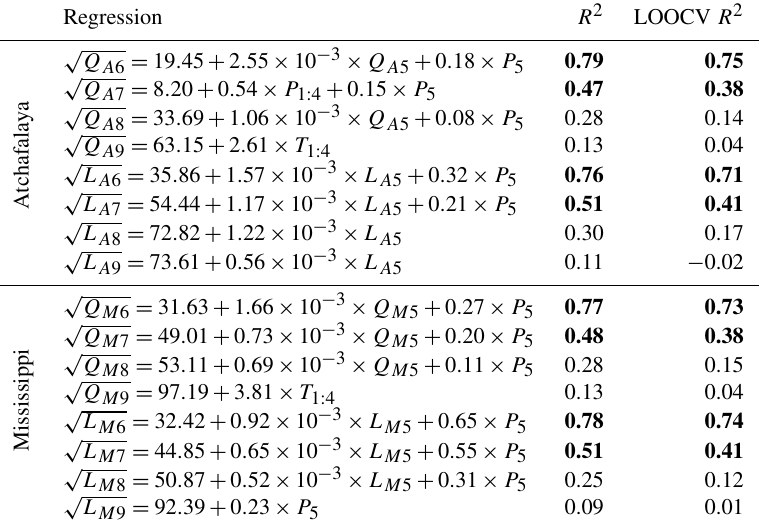
Table 1. Regressions for monthly Atchafalaya and Mississippi river discharge ( Q A and Q M , m 3 s − 1 ) and bioavailable nitrogen loading ( L A and L M ; Mgmo − 1 ). Variable subscript numbers represent months. For example, P 1 : 4 represents average Mississippi River basin precipitation for January–April. R 2 values are presented for the model calibrated to all data and for the leave-one-out cross-validation (LOOCV). Bold R 2 values ( > 0.30) indicate models used for selection of relevant years in hypoxia